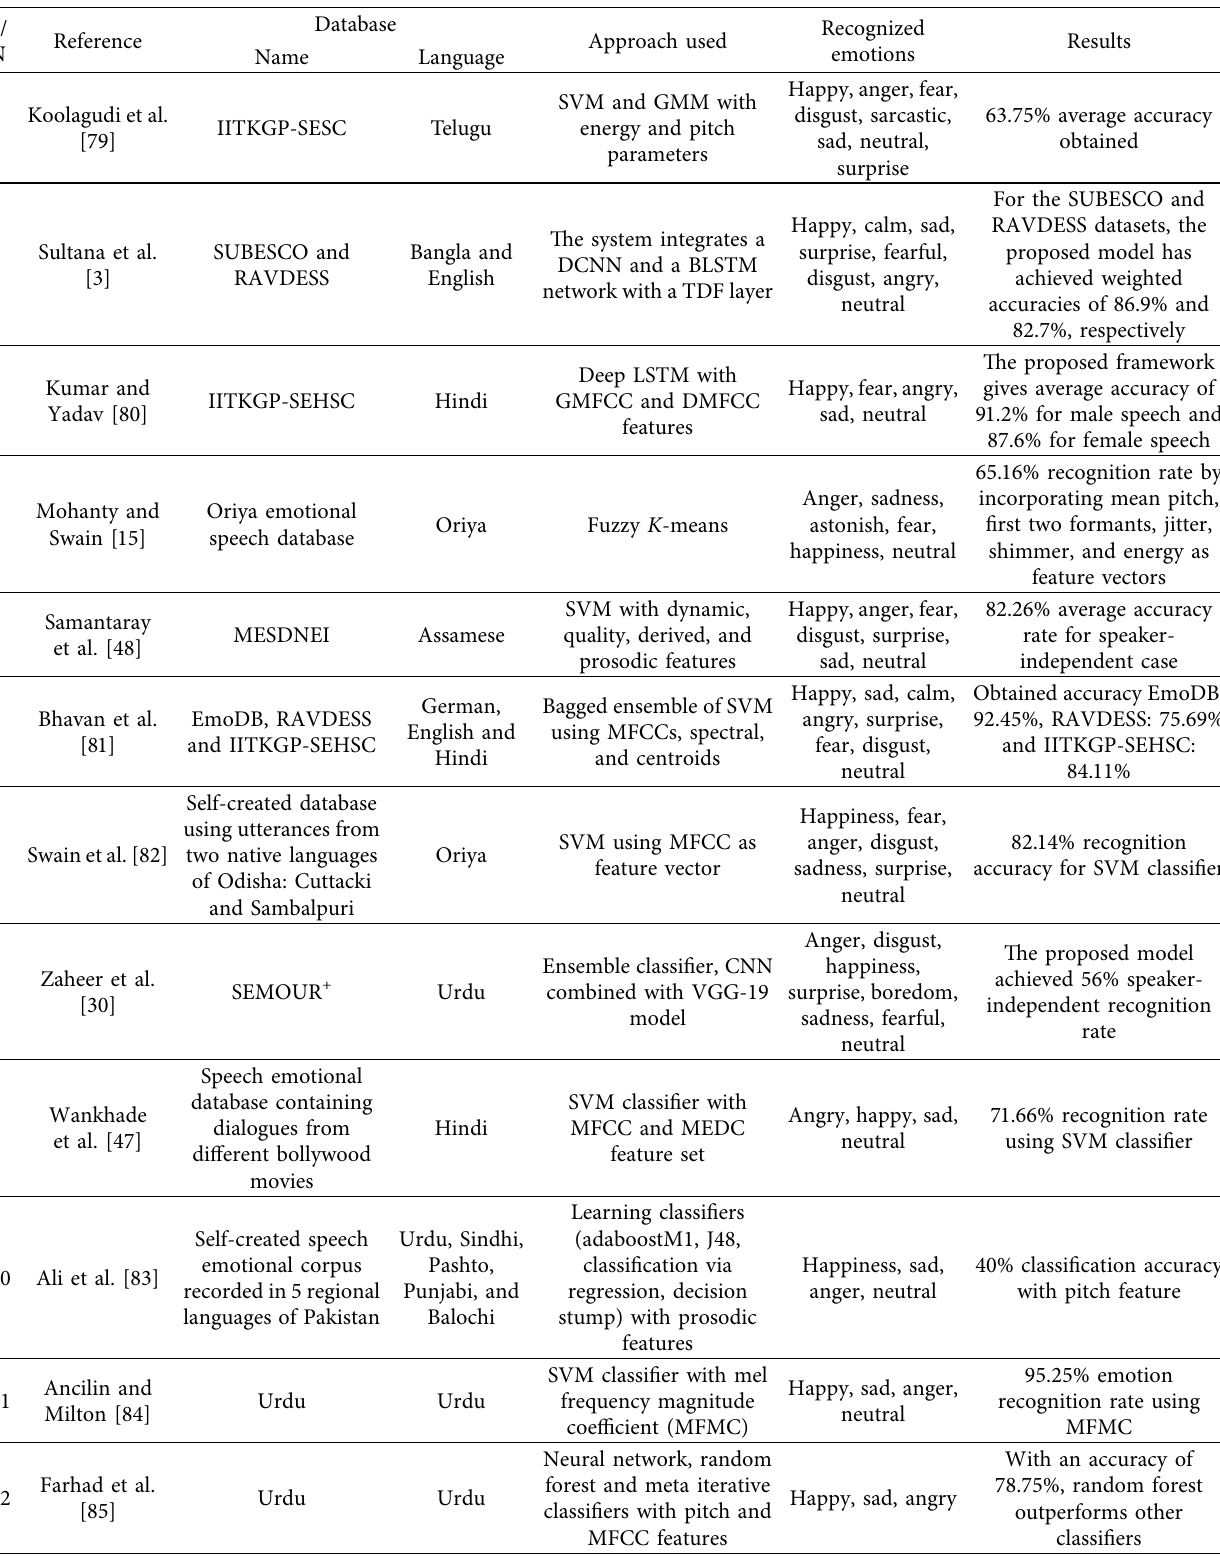
Table 2: Review of some speech emotion recognition experiments for Indo-Aryan and Dravidian languages. S/